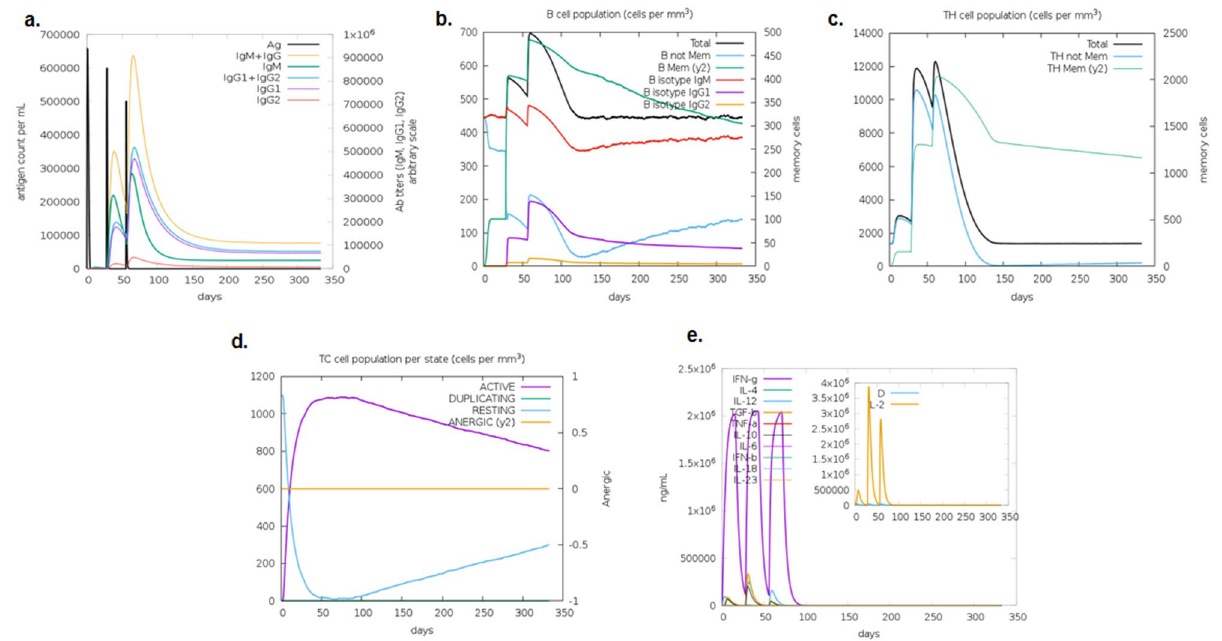
Figure 7. Immune stimulation using in silico C-ImmSim server after antigen 3 dose injection of vaccine construct 61 , ( a ). Production of the immunoglobulin after antigen injections (black vertical lines); detailed subclasses are showed as coloured peaks, ( b ) . Evolution of B-cell populations, ( c ). Th cell population evolution, ( d ). T-cytotoxic cell populations, ( e ). Production of cytokines &